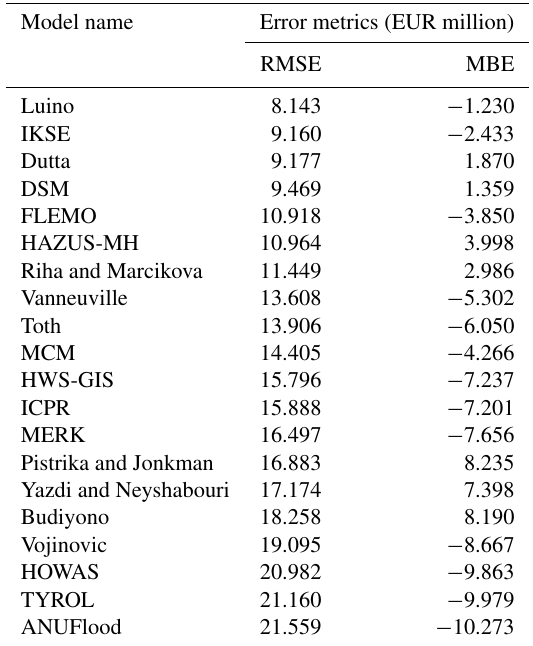
R. Figueiredo et al.: Multi-model ensembles for assessment of flood losses and associated uncertainty Table 3. Results of individual model applications in the Mulde case: root mean square error (RMSE) and mean bias error (MBE), sorted by RMSE.